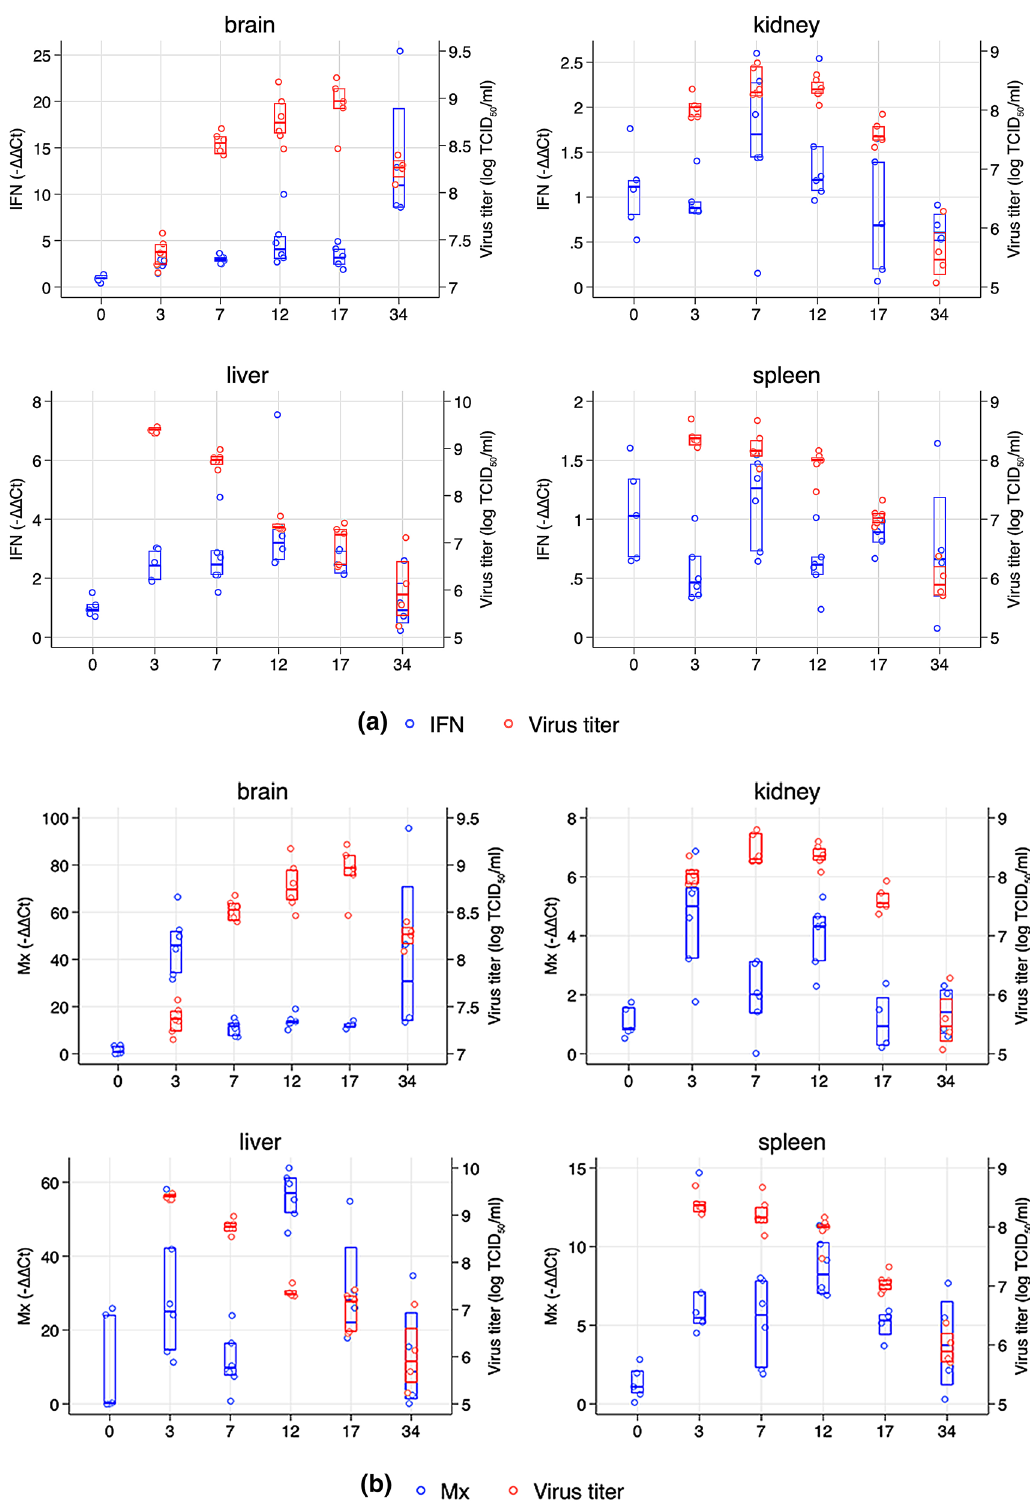
Figure 6. ( a ) IFN-ß expression in all organs over the course of the experiment. X-axis shows days post challenge while the y-axis shows relative gene expression (2 ddCt - left axis) and virus titer (log TCID 50 , right axis). Median and 25/75% percentile is shown for IFN and virus titer. ( b ) Mx expression and virus titer in different organs over the course of the experiment. X-axis shows days post challenge while the y-axis shows relative gene expression (2 ddCt -left axis) and virus titer (log TCID 50 , right axis). Median and 25/75% percentile is shown for Mx and virus